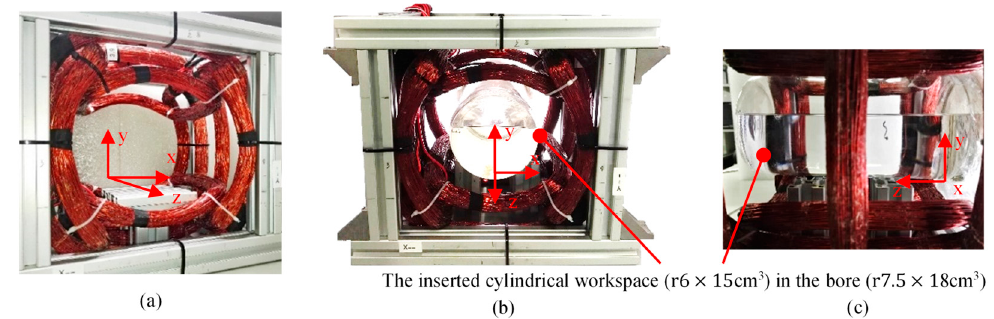
Figure 1. The HyBrid system. ( a ) a large bore. ( b ) and ( c ) the front and side view of a scheme to manipulate a helical microswimmer to swim in a large cylinder containing 350-cst. silicon oil which is inserted into the bore.